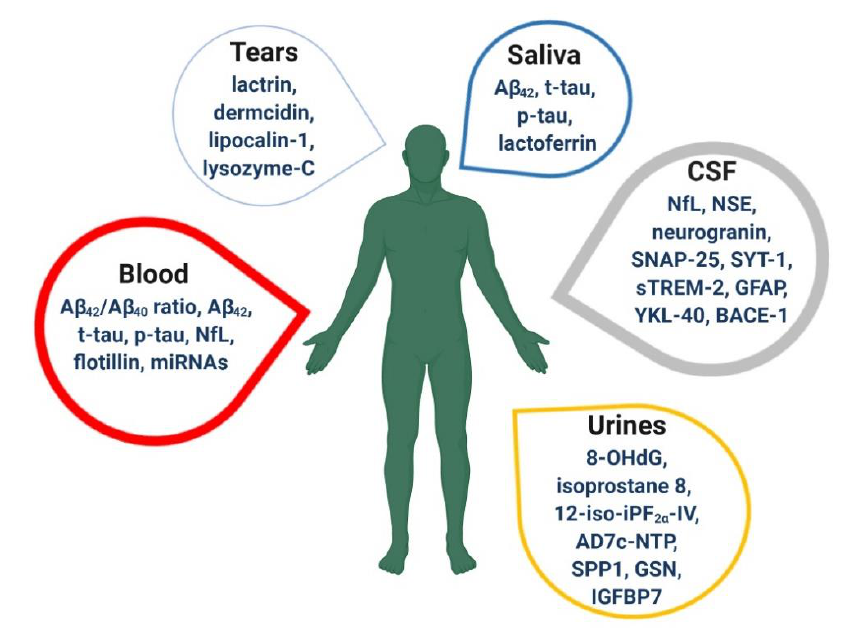
Figure 2. Emerging biomarkers in cerebrospinal fluid (CSF) and alternative biological fluids. For each of them, the thickness of the box is proportional to the number of articles in English searched in Pubmed database on 24 June 2020 using the keywords: “biomarker” AND “Alzheimer’s disease” AND the type of fluid.